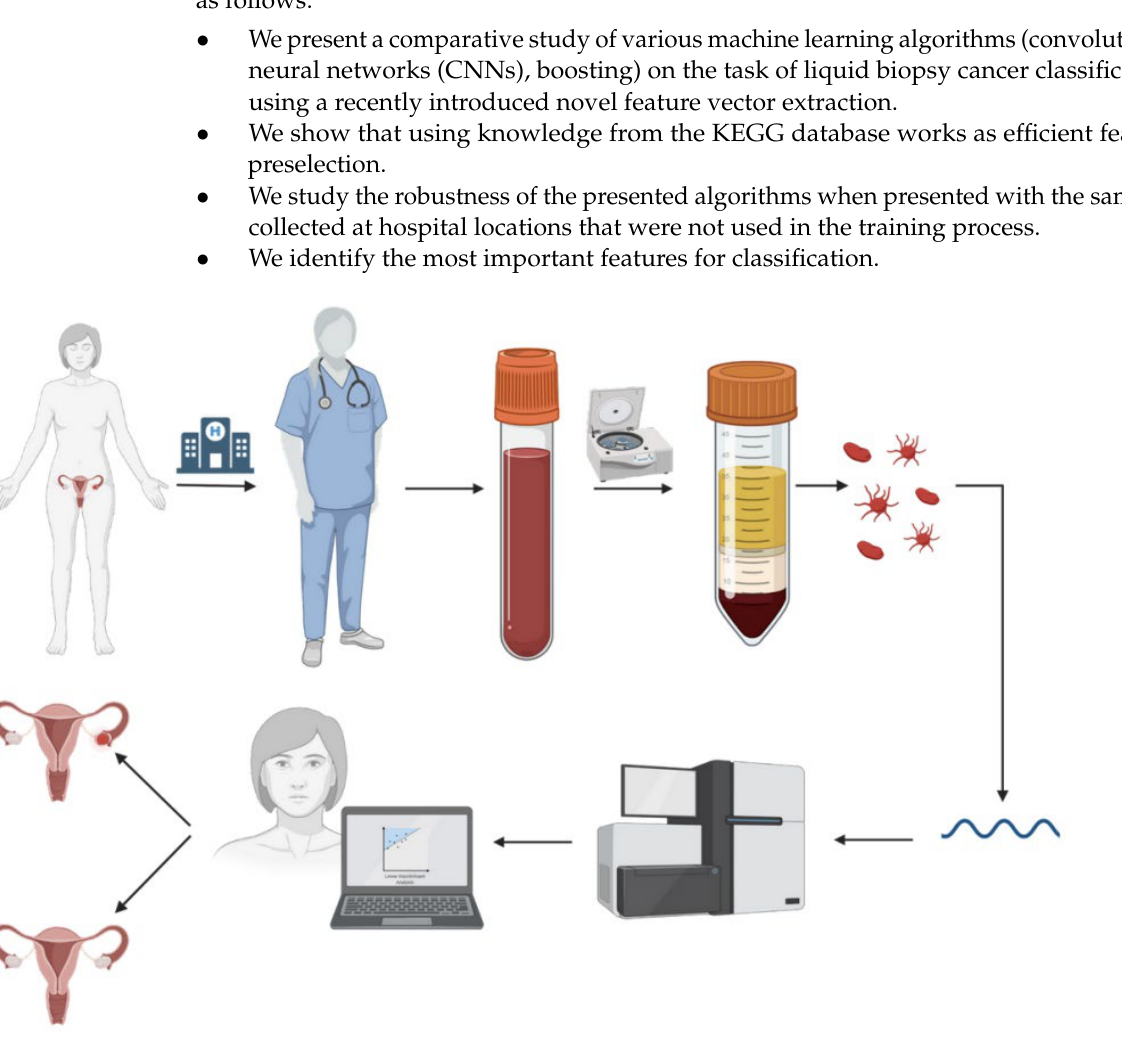
Figure 1. General workflow of sample collection and further classification. First, a patient treated at the hospital is enrolled in the study based on the inclusion criteria specified by clinicians; next, a blood sample is collected, and platelets are processed, RNA is extracted from platelets and sequenced. Then, bioinformatics processing follows, and a machine learning model is used for sample classification (healthy donor versus patient with diagnosed